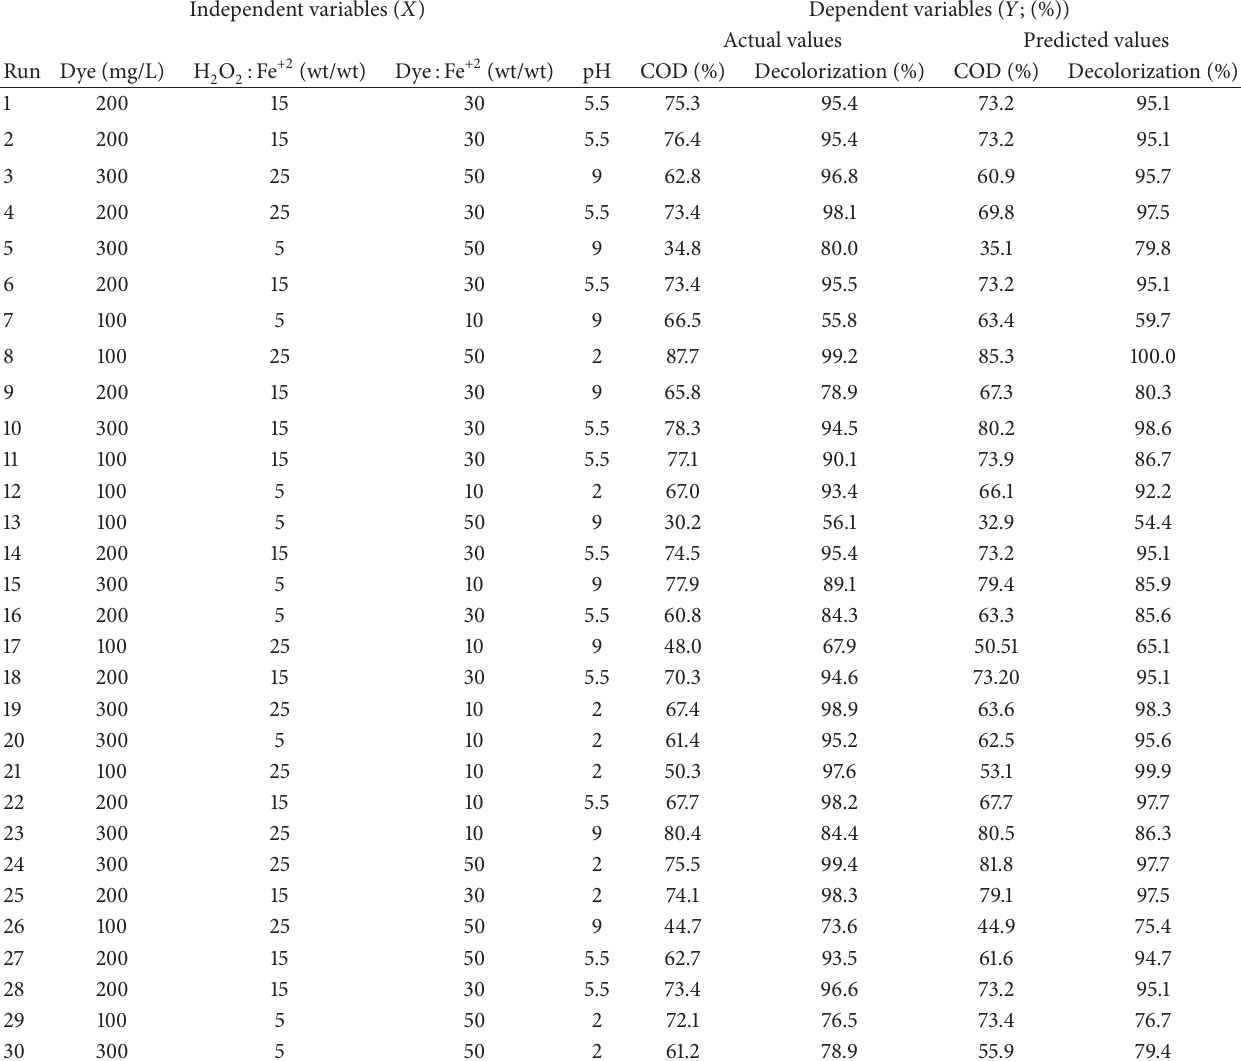
Table 2: Experimental design matrix, experimental runs, and predicted values on COD removal and decolorization efficiency. Independent variables ( 𝑋